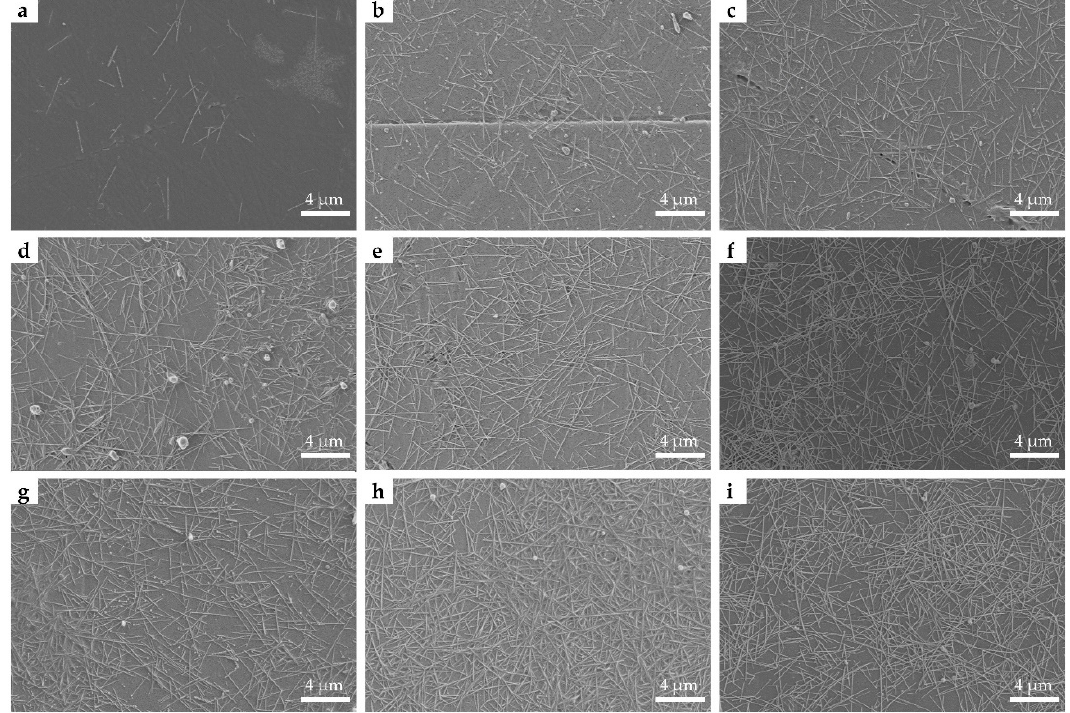
Figure 4. SEM images of printed patterns with the printed layers of 2 ( a ), 4 ( b ), 6 ( c ), 8 ( d ), 10 ( e ), 12 ( f ), 14 ( g ), 16 ( h ), and 18 layers ( i ).